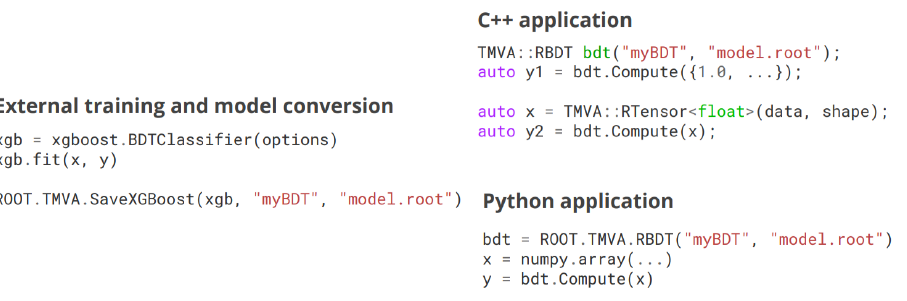
Figure 4. TMVA workflow with externally trained model and application in C ++ and